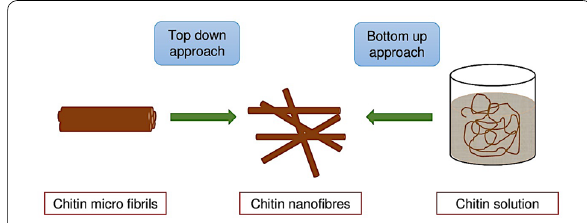
Fig. 6 Top–down and bottom–up approaches of chitin nanofibers preparation